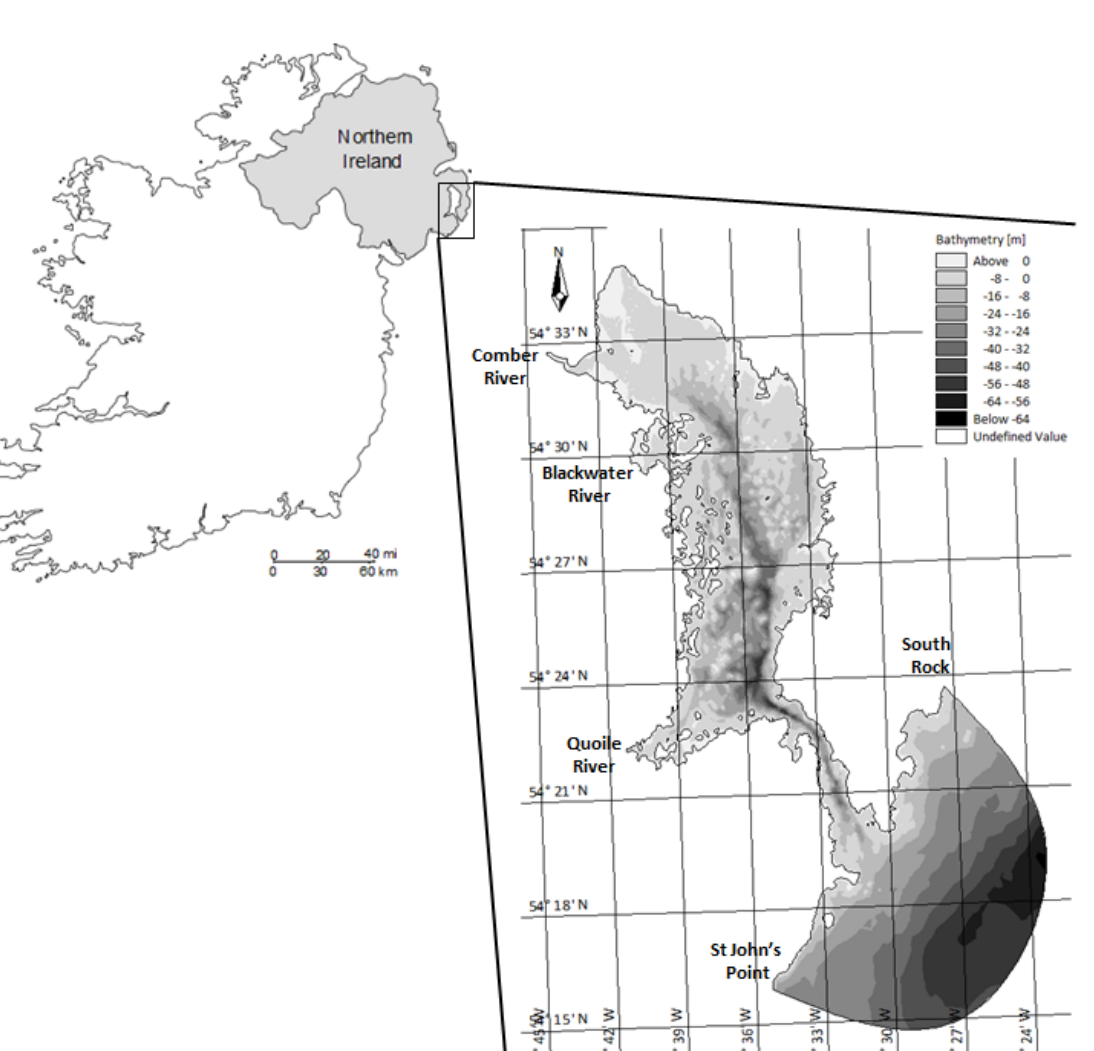
Figure 1. Location of Strangford Lough in Northern Ireland and the Strangford Lough model